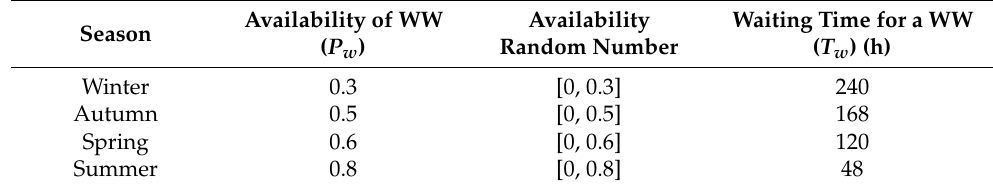
Table 10. Availability of weather window and waiting